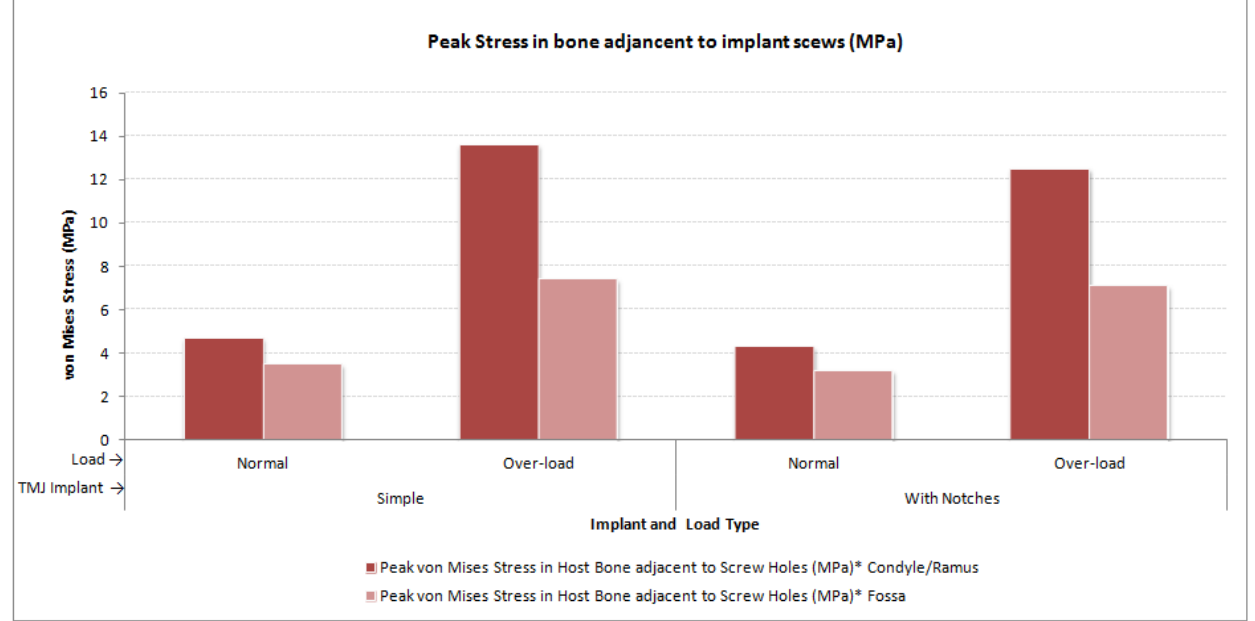
Figure 33. Peak von Mises stress in the mandibular and fossa bone adjacent to fixation screws of total TMJ prostheses during FE simulations under normal and worst-case/over-load configurations.